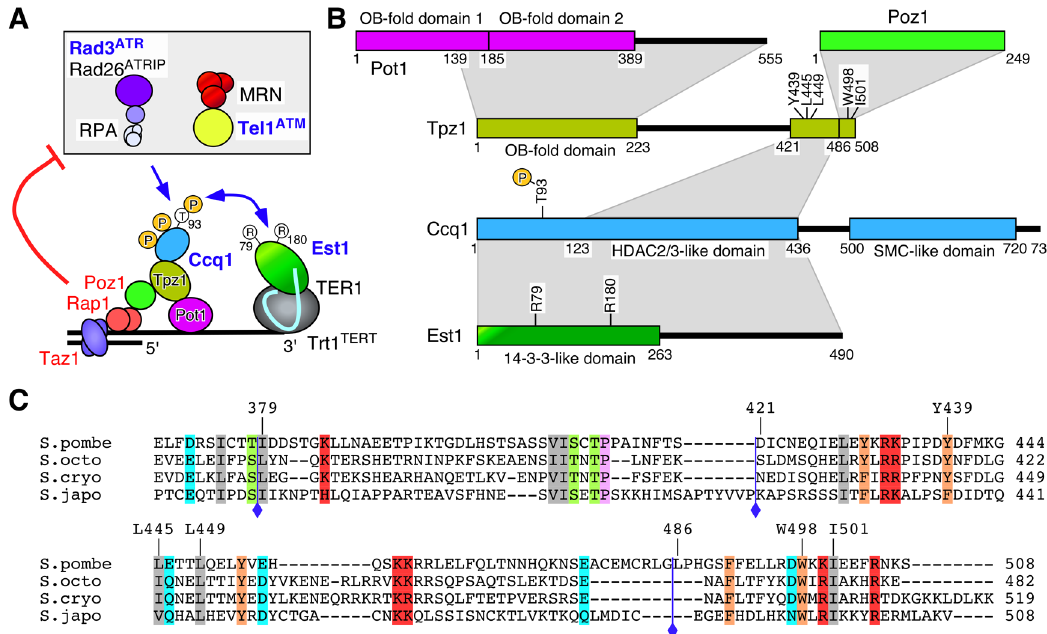
Figure 1. Summary of Tpz1-Ccq1 and Tpz1-Poz1 interaction domains. ( A ) A model of telomere maintenance regulation in fission yeast [12]. Taz1, Rap1 and Poz1 negatively regulate telomere extension by limiting accumulation of Rad3 ATR kinase, Ccq1 Thr93 phosphorylation and telomerase recruitment, while recognition of Ccq1 Thr93 phosphorylation by the 14-3-3-like domain of Est1 promotes telomerase recruitment [12]. ( B ) Summary of protein-protein interaction domains for shelterin and telomerase subunits determined by Y2H assays. The current study identified Tpz1 Y439, L445 and L449 as critical for Tpz1-Ccq1 interaction and Tpz1 W498 and I501 as critical for Tpz1-Poz1 interaction. A previous study has identified Ccq1 T93 and Est1 R79 and R180 as critical for Ccq1-Est1 interaction [12]. ( C ) Sequence alignment of Tpz1 region responsible for Tpz1-Ccq1 and Tpz1-Poz1 interaction in S. pombe and corresponding regions from three additional Schizosaccharomyces species ( S. octosporus , S. cryophilus and S. japonicus ). Blue diamonds indicate a previously defined Ccq1/Poz1 binding domain (379–508) [31], and newly defined Ccq1 binding (421–485) and Poz1 binding (486–508) domains. In addition, amino acid residues critical for Tpz1-Ccq1 (Y439, L445 and L449) and Tpz1-Poz1 (W498 and I501) interactions are